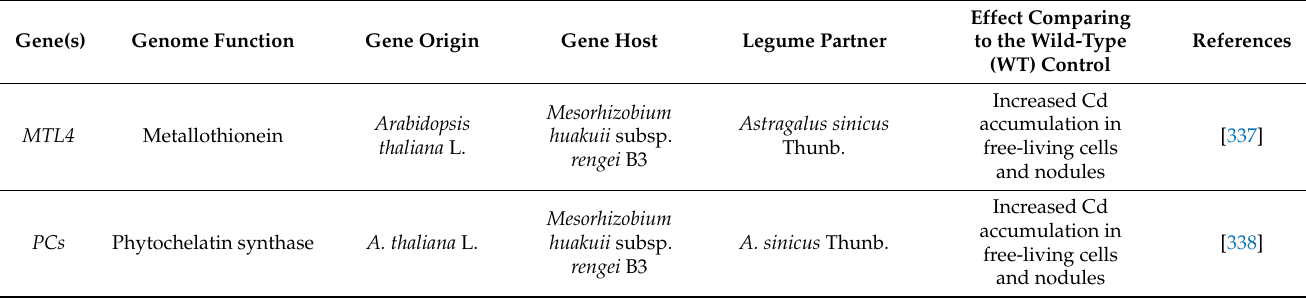
Table 4. Summary of studies using transgenic rhizobia in association with leguminous plants for heavy metal